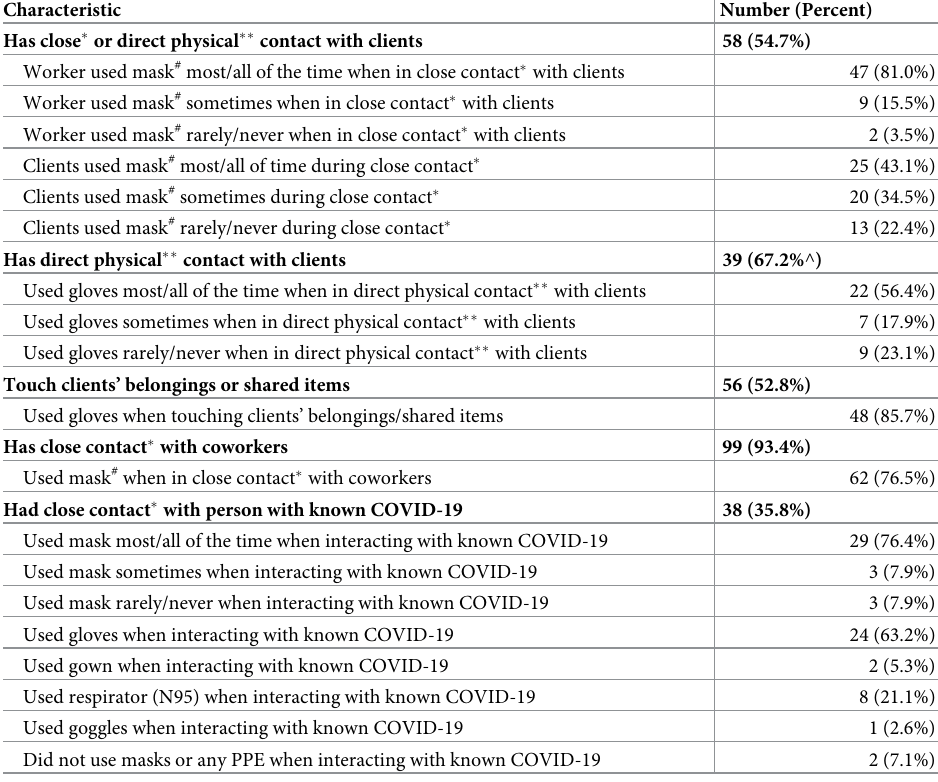
3 (7.9%) 24 (63.2%) 2 (5.3%) 8